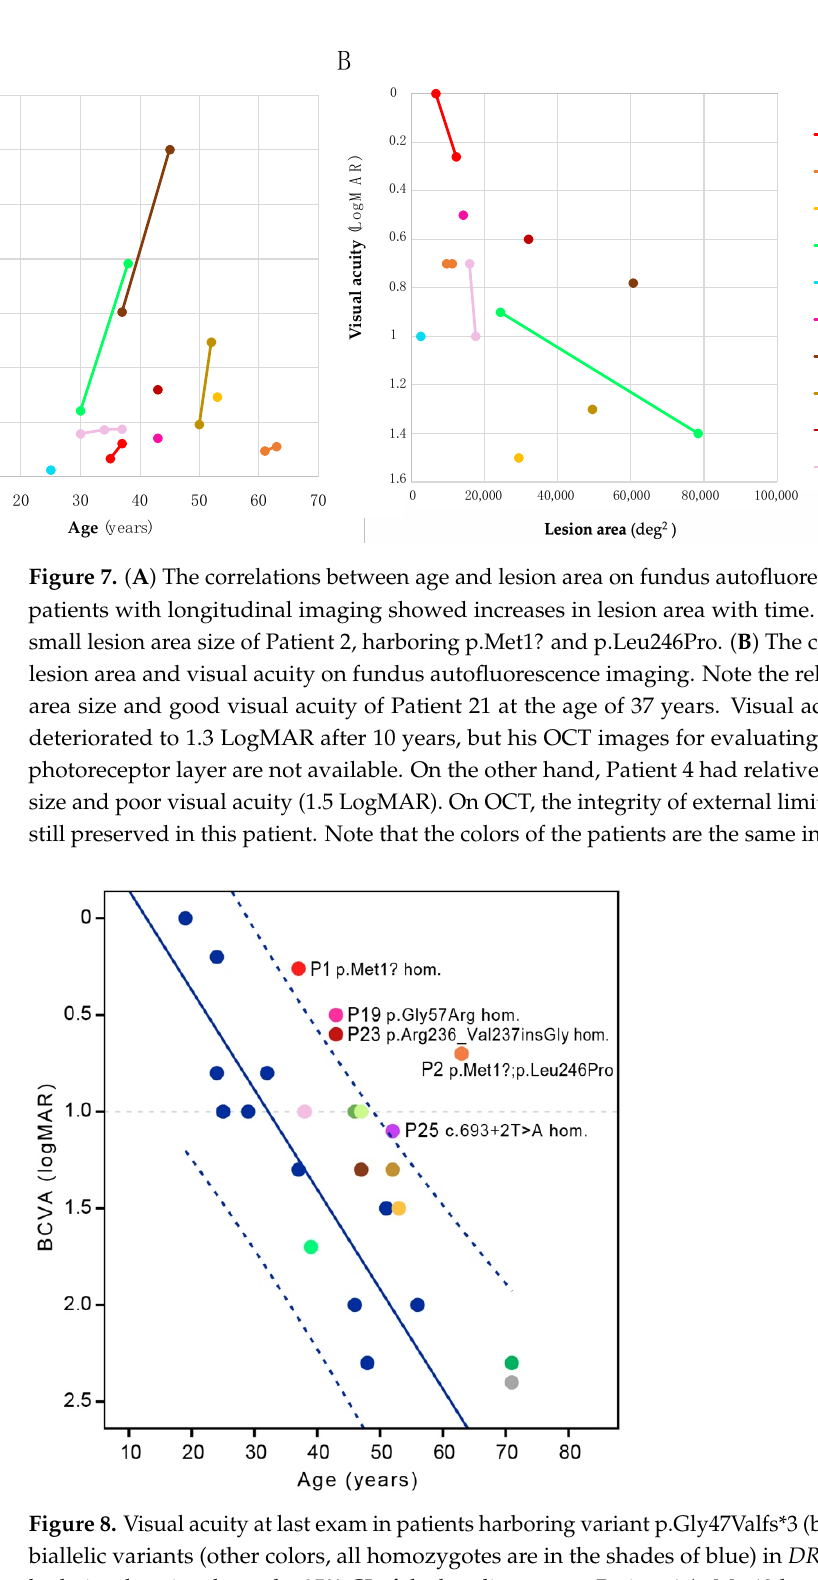
Figure 6. Visual acuity in patients with DRAM2 retinopathy and its worsening through follow-up. Patient 1 (p.Met1?; p.Met1?) had relatively good visual acuity in comparison with other patients harboring two start loss. Patient 2, harboring one missense allele (p.Met1?; p.Leu246Pro), had no- ticeably better visual acuity in comparison with the other patients. Note that all patients with path- ogenic variant p.Gly47Valfs*3 are in the shades of blue. Note that the colors of the patients are the same in Figures 5–8.